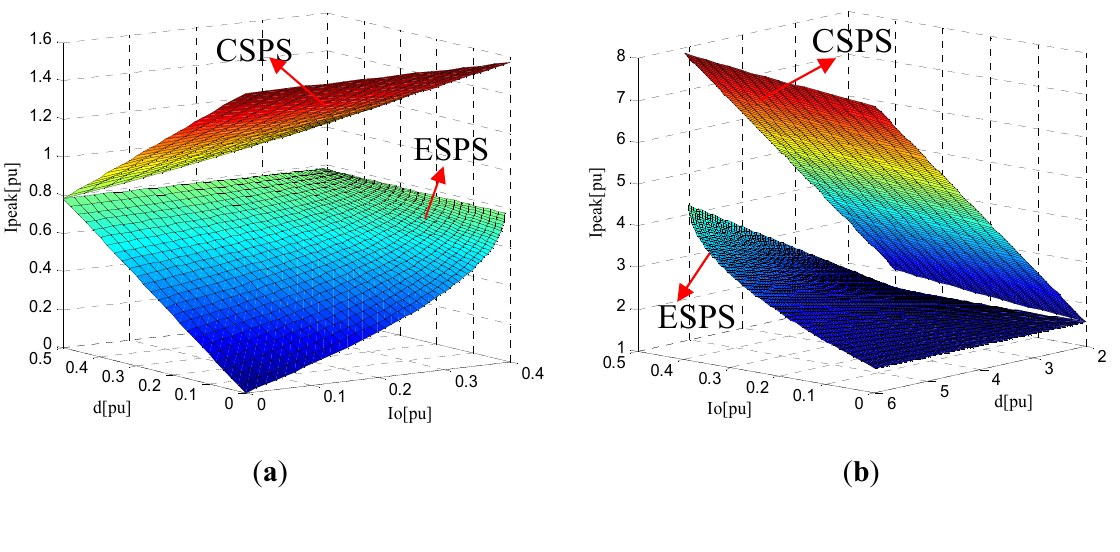
Figure 7. Curves of the normalized peak current varied with I